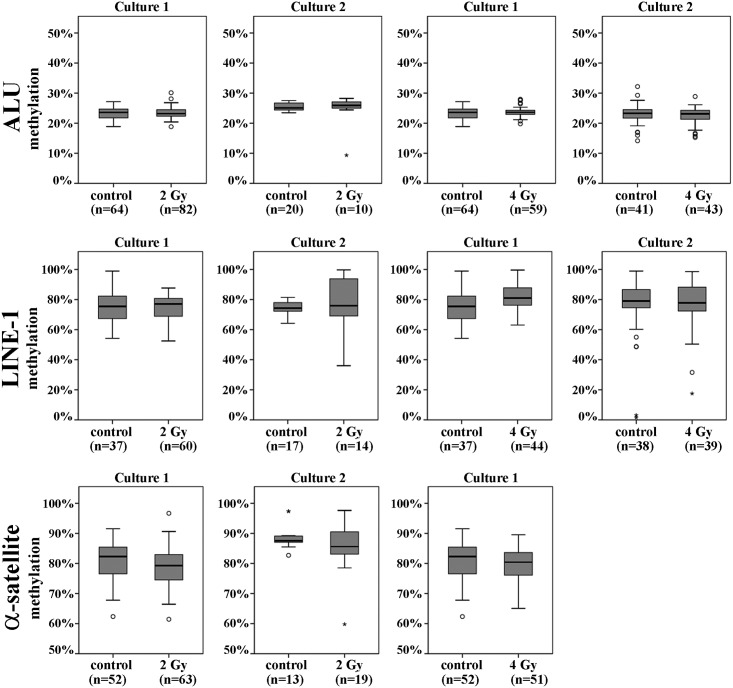
Box plots showing the distribution of repeat DNA methylation in single cells.DNA methylation of interspersed ALU and LINE-1 repeats, and α-satellite DNA was determined by bisulfite pyrosequencing in individual fibroblasts from two independent cultures at 24 h after irradiation with 2 Gy and 4 Gy, respectively. For each culture, time point, and dose, the number of analyzed cells is given in parenthesis. The median is represented by a horizontal line. The bottom of the box indicates the 25th percentile, the top the 75th percentile. Outliers are shown as circles and extreme outliers as stars.